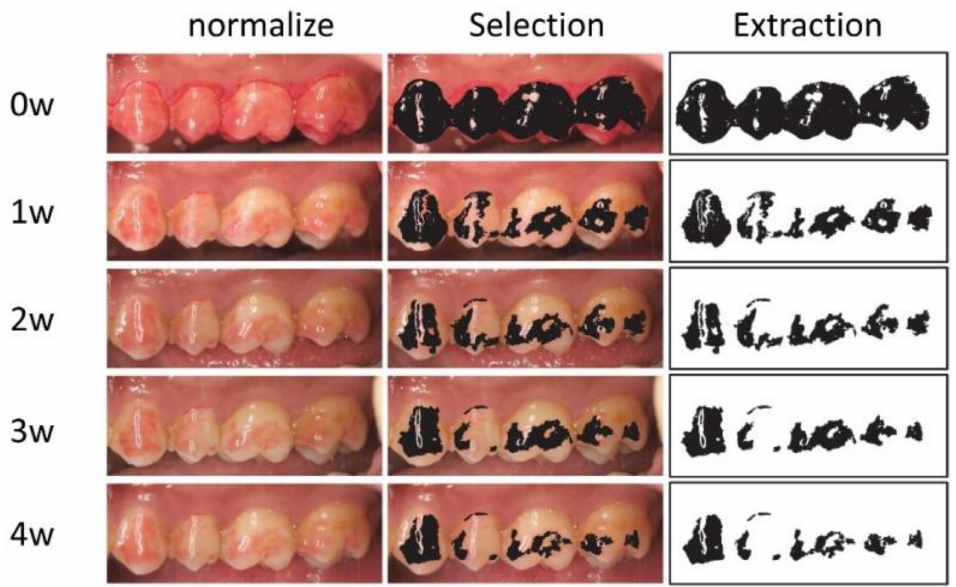
Figure 1. Intraoral photograph forms and adjusted color